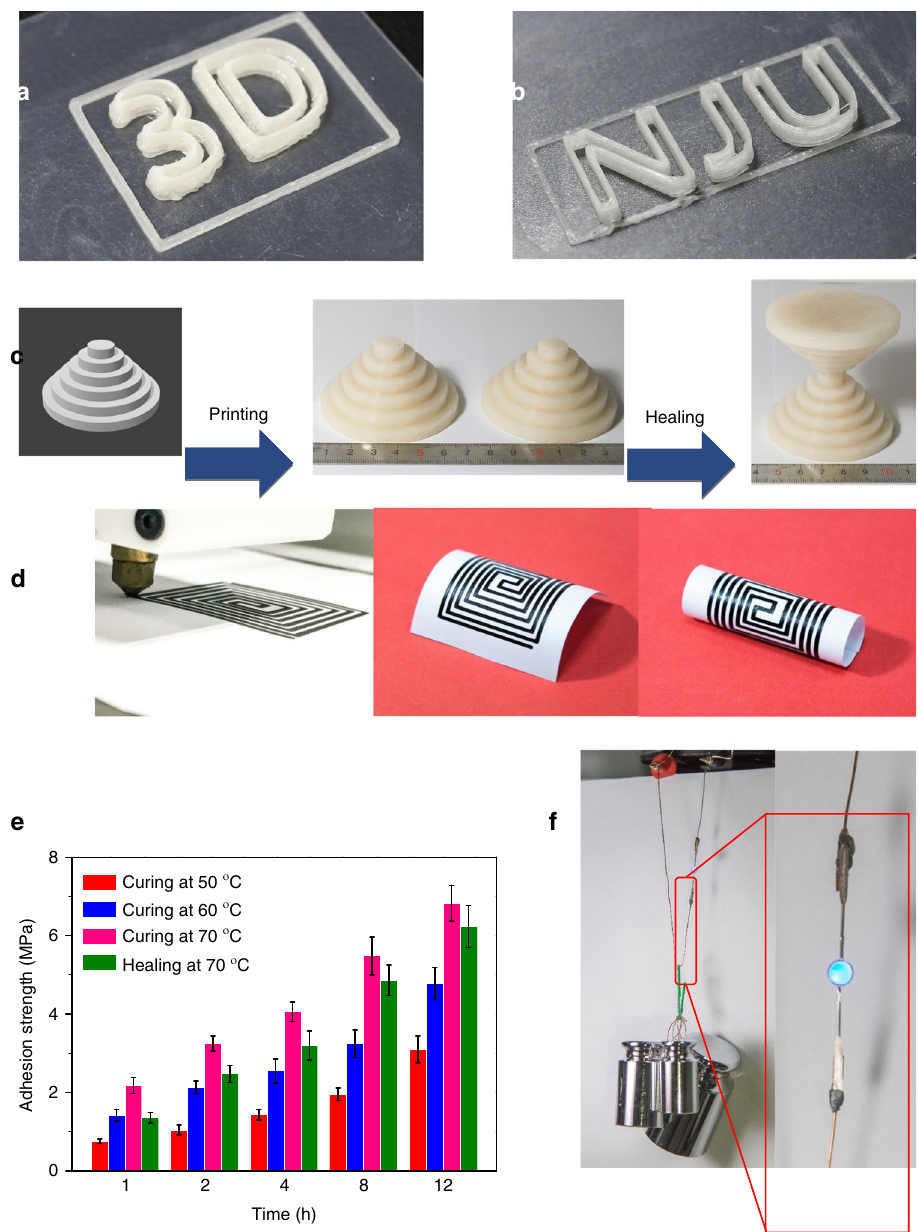
Fig. 4 Applications of PDMS-COO-Zn polymer. a , b Various of 3D objects printed from the PDMS-COO-Zn polymer. c The irregular objects obtained by 3D printing. d An electrical circuit based on the PDMS-COO-Zn / graphene composite could be printed on paper, and the as-prepared device can be reshaped. e The effect of cure time and temperature upon lap shear adhesion with the PDMS-COO-Zn / graphene composite as conducting adhesive. Error bars are the s.d. from triplicate measurements. f A circuit that glued and conducted by PDMS-COO-Zn / graphene composite could sustain a weight of 800